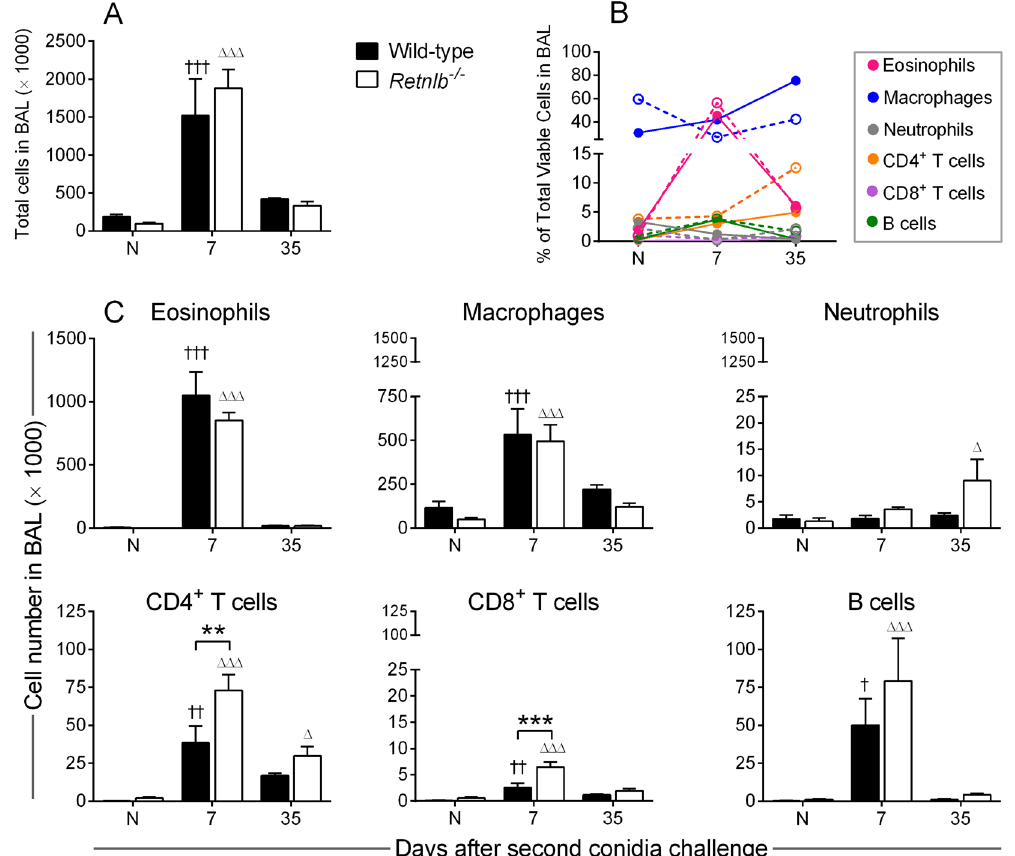
Figure 2. RELM- β has a minimal impact on airway inflammation. Immune cells were recruited into the airways (collected by bronchoalveolar lavage) in both Retnlb sufficient (wild-type) and deficient (KO) mice ( A ). Cell populations normalized to cell number showed slight variations in the kinetics between WT (solid circles) and KO (open circles) mice ( B ). Absolute cell numbers suggest no major differences in innate cell populations at early the early time point although neutrophils were present at the late time point in KO airways ( C ). RELM- β deficient mice had more T cells, while B cell numbers were similar ( C ). Data are represented as the mean and SD of n = 4–7 mice/group in one representative study of two independent studies. Data at each time point were compared by two-way ANOVA with Dunnett’s and Sidak’s multiple comparisons test to their naïve controls († and Δ ), and between genotypes ( * ) respectively. One, two, and three symbols represent P < 0.05, P < 0.01, and P < 0.001 correspondingly. N –